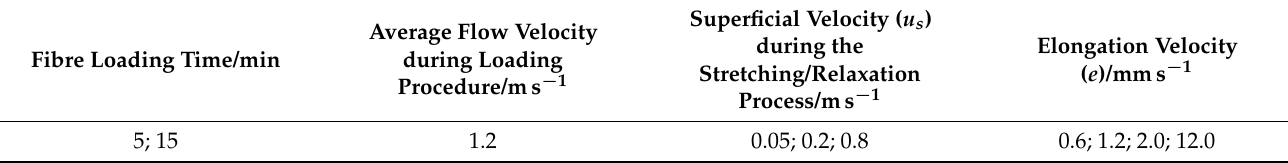
Table 1. Variation of loading time, average flow velocity, superficial velocity and elongation